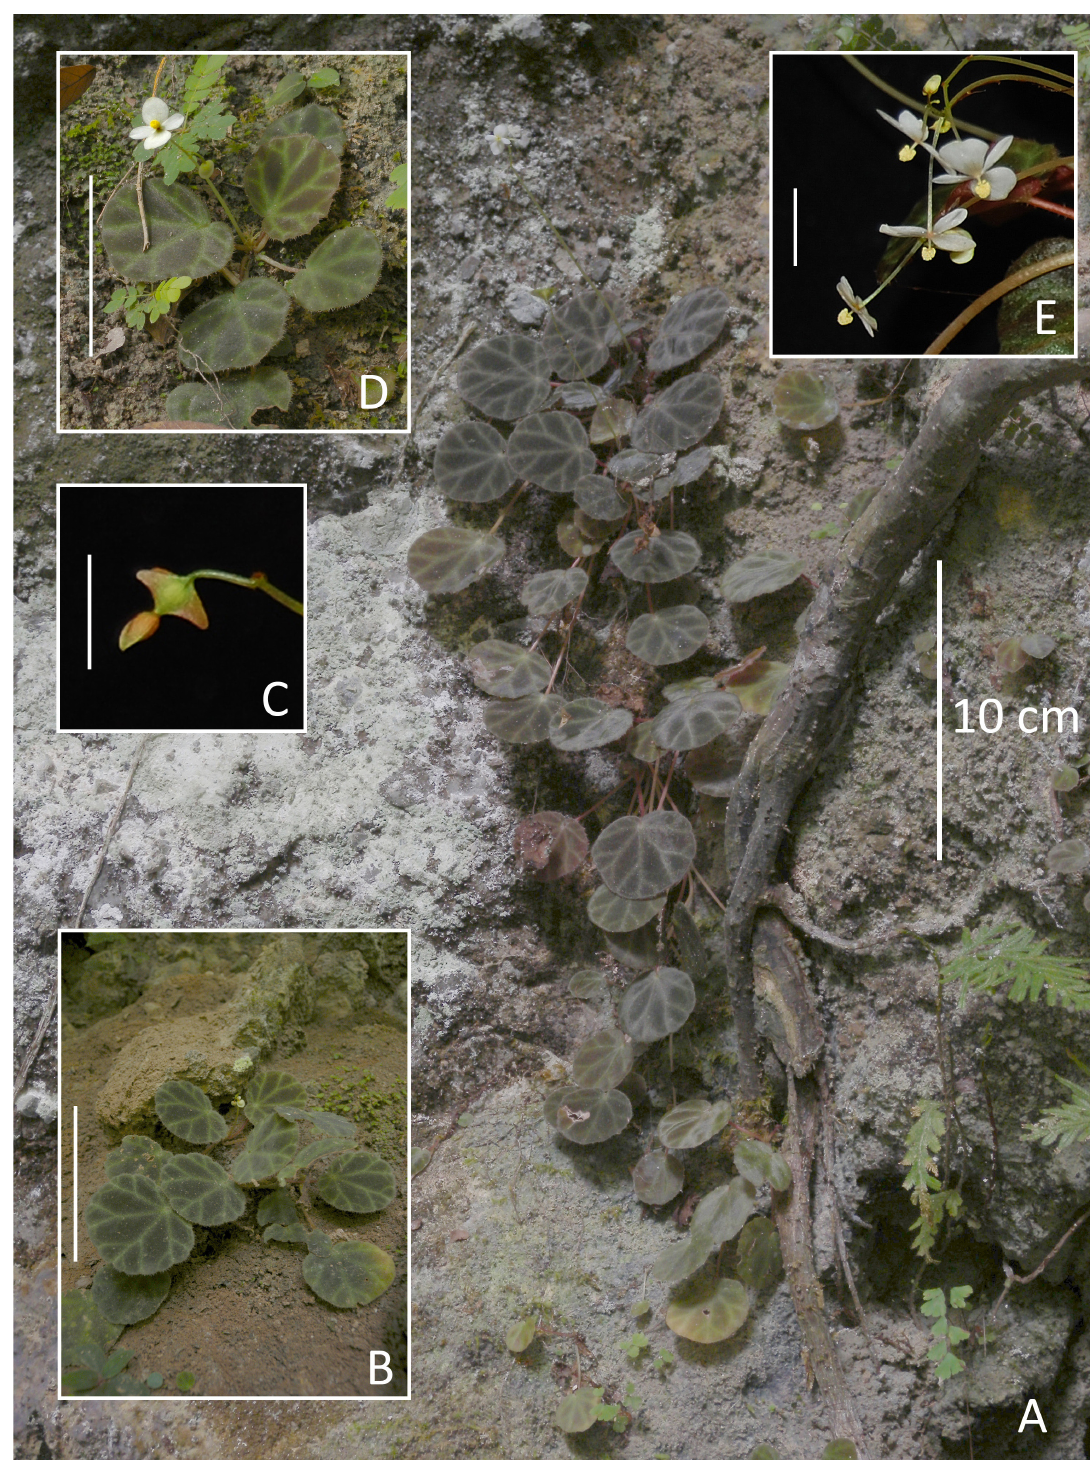
Fig. 14. Begonia olivacea Ardi sp. nov. A . Habit, showing petiole elongation in older leaves. B . Green colour form. C . Female flower bud and ovary. D . Plant with male flower. E . Male flowers. A, B, D photographed at the type locality of Simolap; C, E taken from a plant in cultivation at Bogor Botanic Garden (accession B2013070037, derived from material collected at the type locality). Scale bars on insets: B, D = 5 cm; C, E = 1